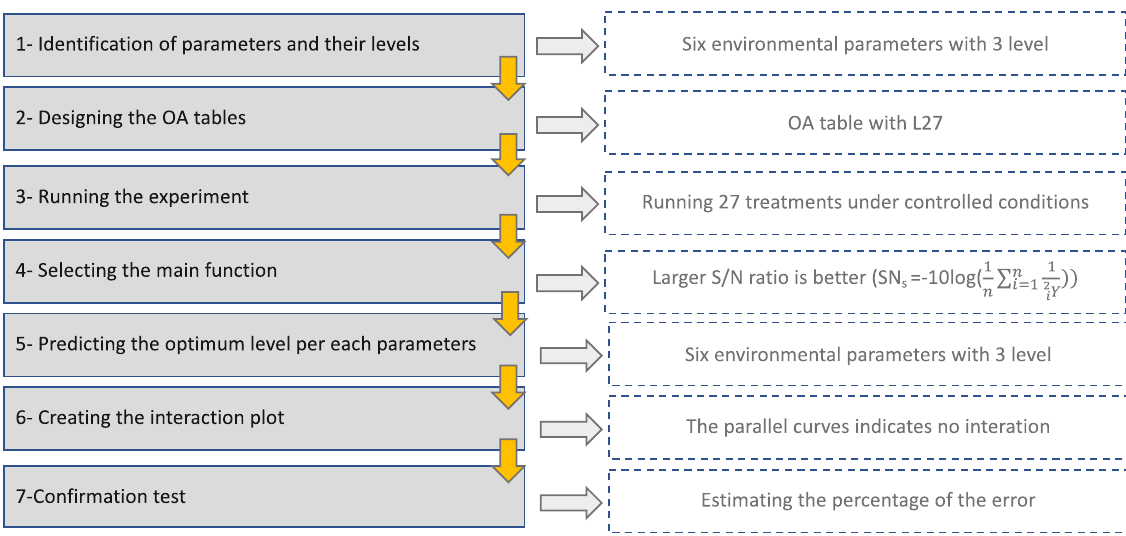
Figure 2. The used workflow to analyse the data using Taguchi approach in the current stud (S: Signal N: Noise